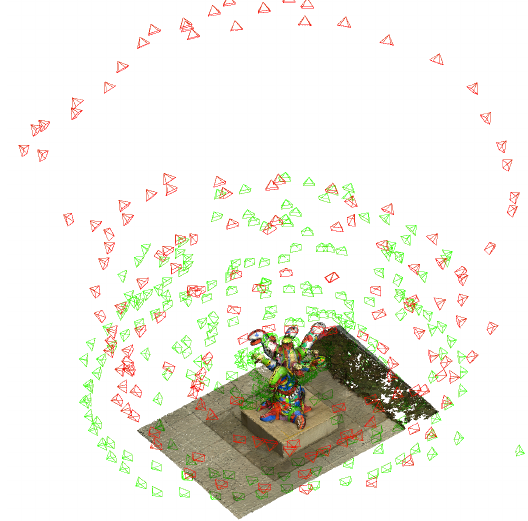
Figure 6: Fusion result of two UAV-based blocks of acquisition on Statue dataset